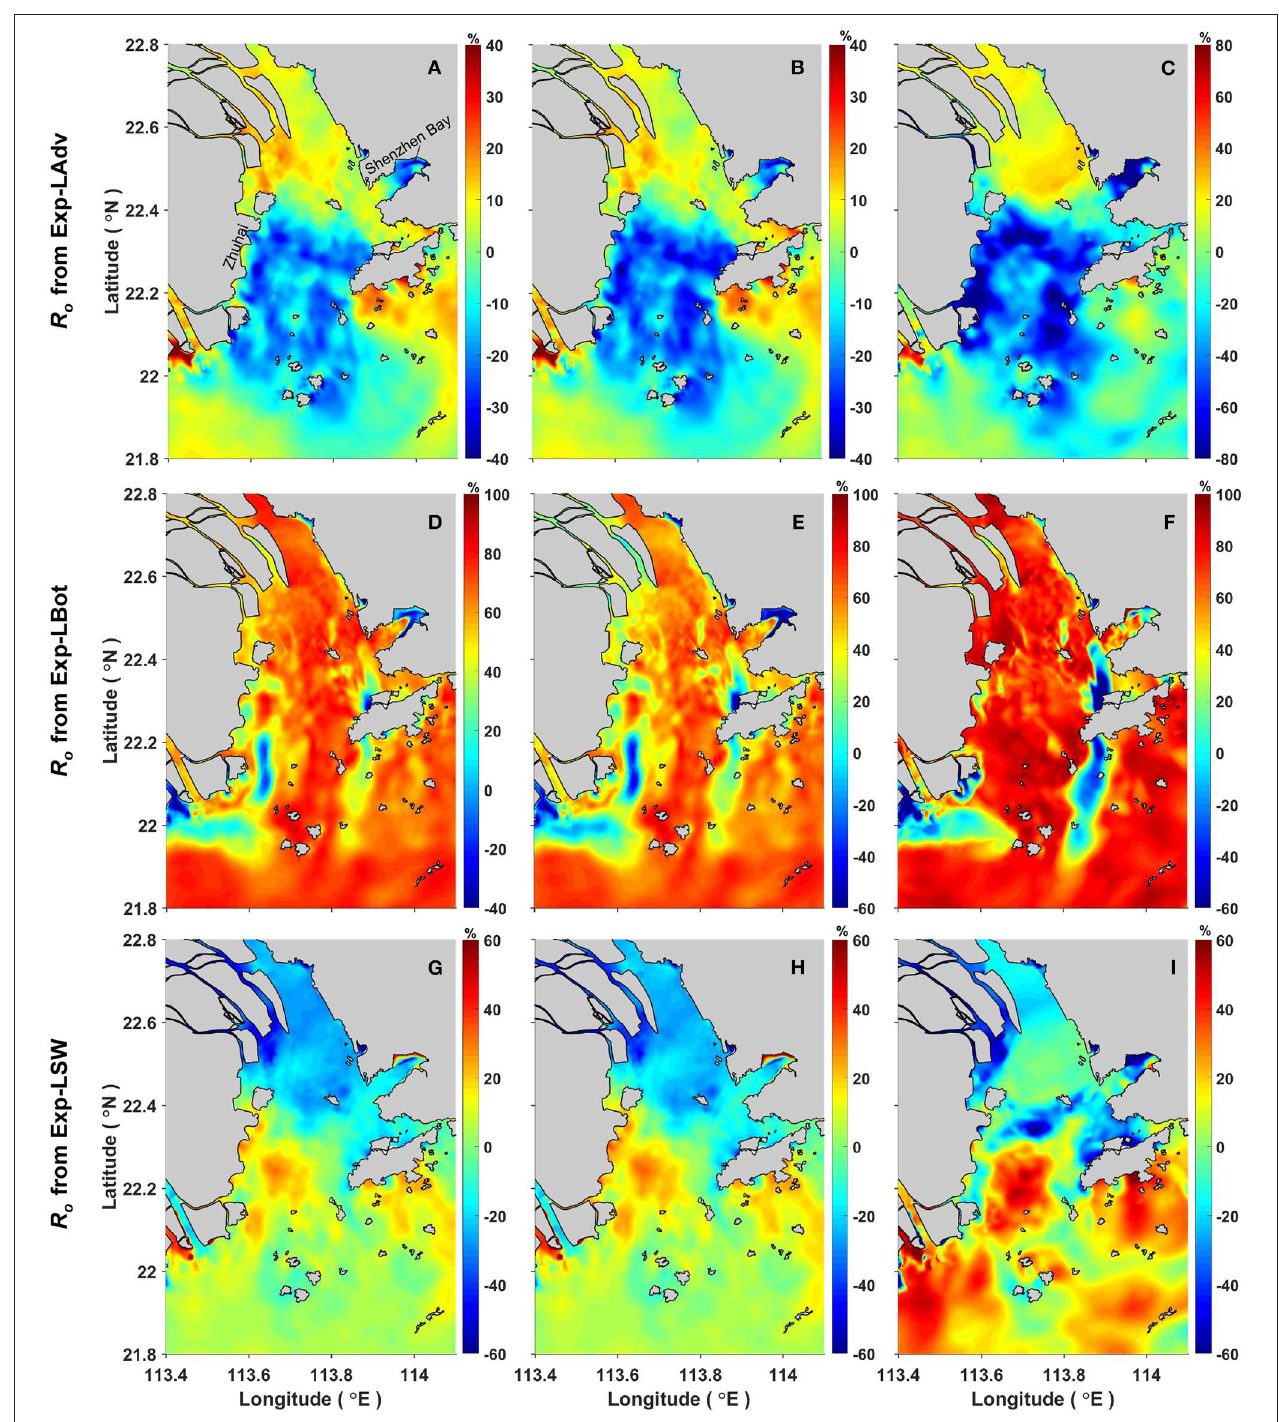
FIGURE 9 | Spatial distributions of the reduction ratio R o in the PRE. (A–C) Show the R o values calculated by using RMS ( ζ TSI ), I r , and MAX ( ζ TSI ), respectively, from the reduced experiment Exp-LAdv; (D–F) show the R o values calculated by using RMS ( ζ TSI ), I r , and MAX ( ζ TSI ), respectively, from the reduced experiment Exp-LBot; (G–I) show the R o values calculated by using RMS ( ζ TSI ), I r , and MAX ( ζ TSI ), respectively, from the reduced experiment Exp-LSW.